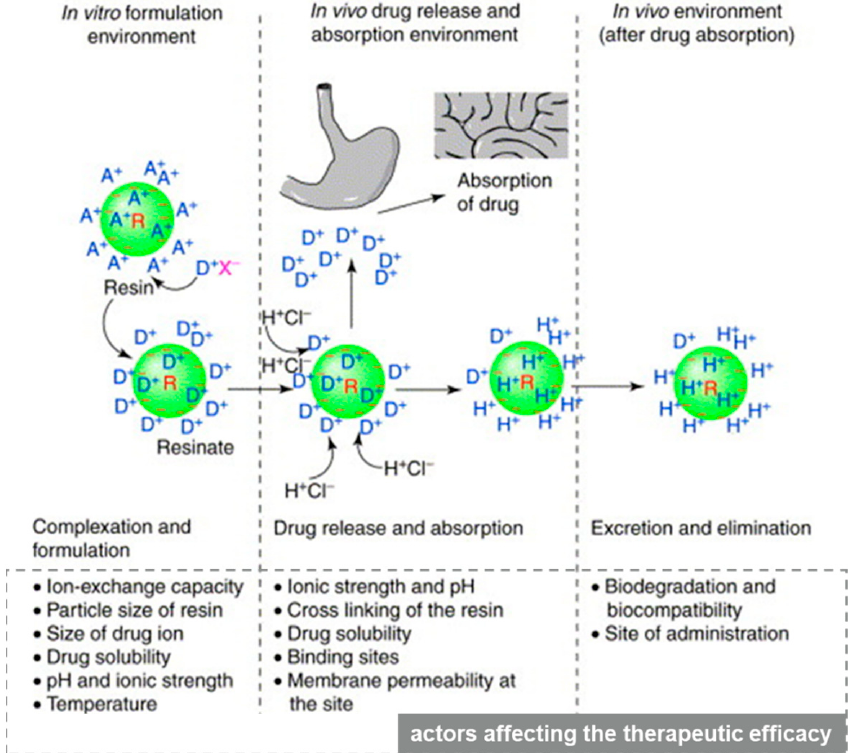
Figure 1. The basis of the ion − exchange process in drug delivery with factors affecting the therapeutic efficacy of the system at each stage. Reprinted by permission from Elsevier Publishers Ltd.: Drug Discovery Today. 2001, 6(17): 905–914, copyright 2021. R and a green circle depict resin; a ‘ − ’ sign depicts the integral ion of the resin, and A + is the counter ion. D + is the drug ion, X − is the ion associated with drug cation and H + CI − is hydrochloric acid. Ions inside and outside the resin indicate ions adsorbed at the surface, as well as at the interior, of the resin structure